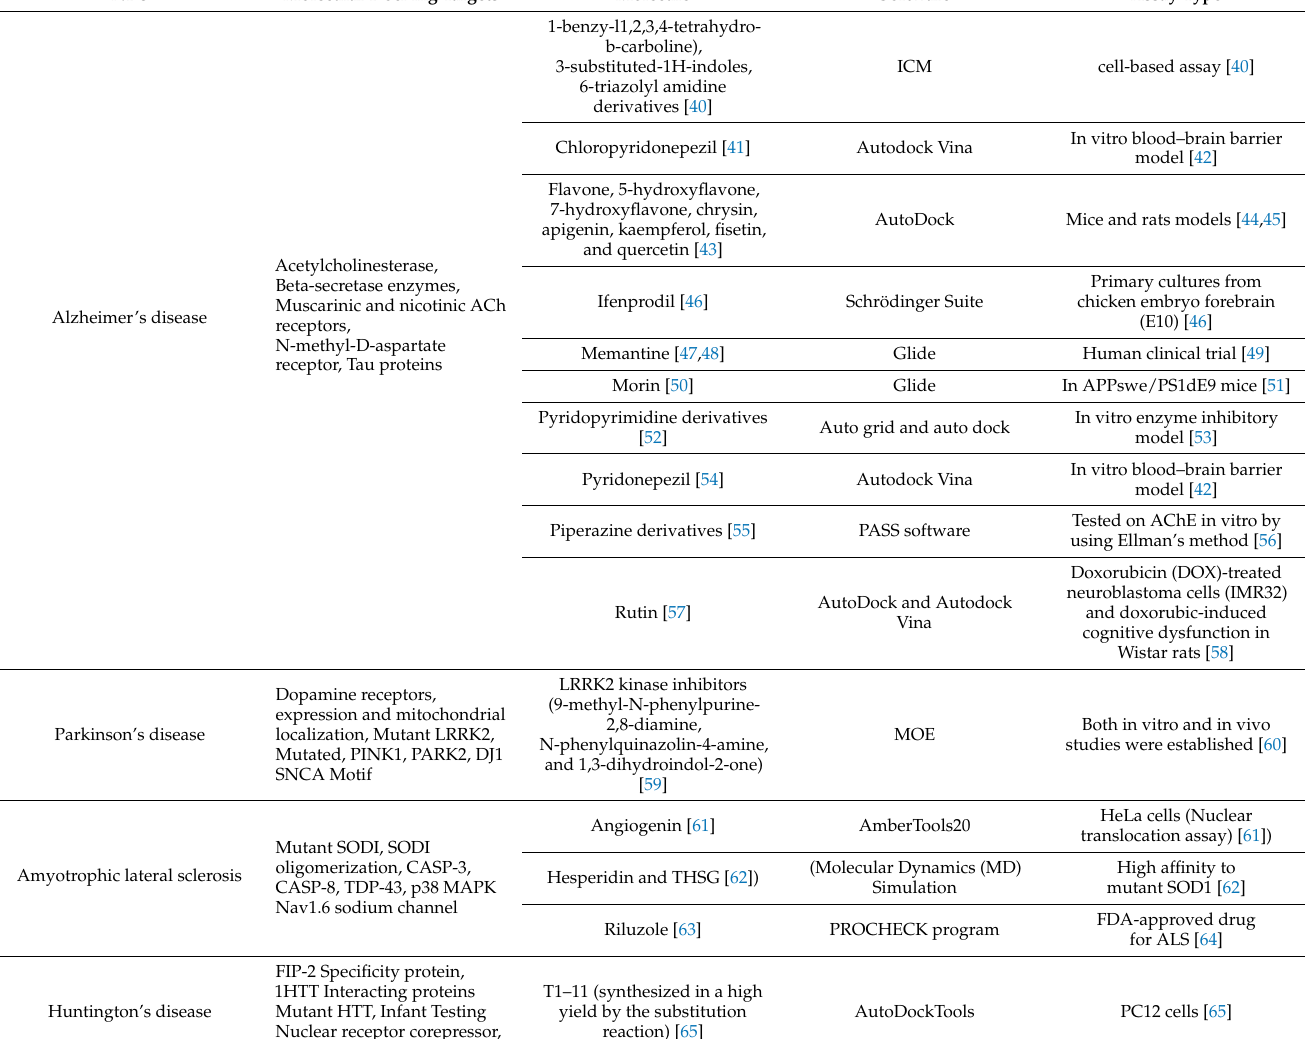
Table 2. NDs with specified molecular targets and selected examples of drugs that have been identified with the aid of in silico drug design. The assay format used to validate each drug is indicated and drugs that progressed to clinical trials are highlighted in